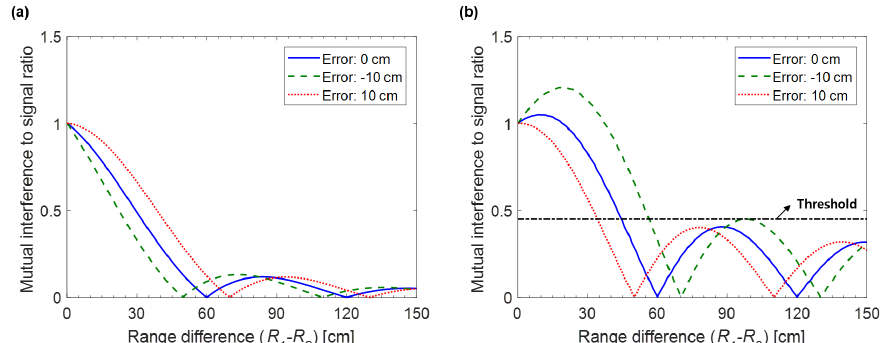
Figure 2. Influence of the mutual interference with varying range difference and position estimation